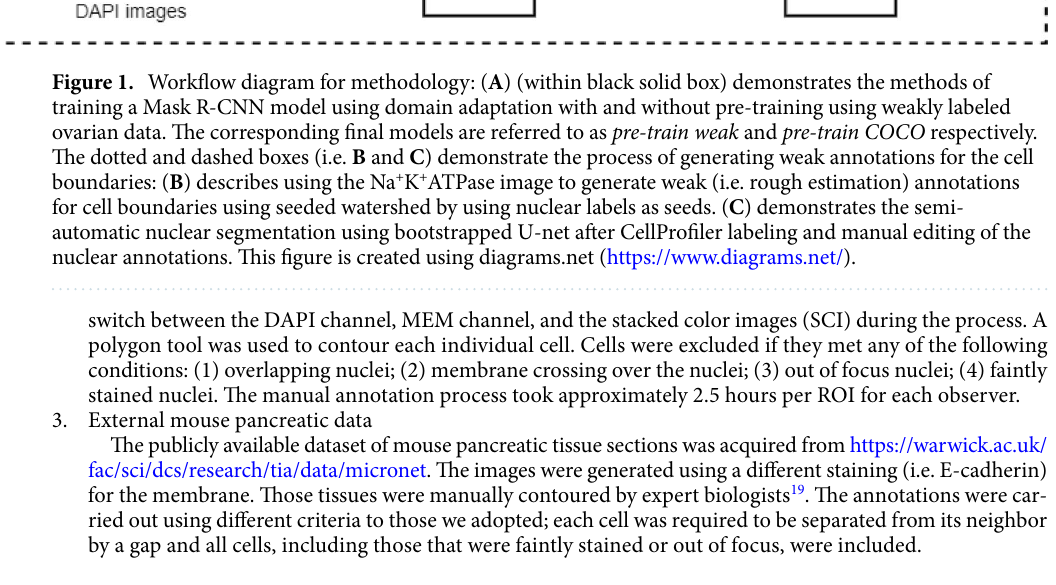
ried out using different criteria to those we adopted; each cell was required to be separated from its neighbor by a gap and all cells, including those that were faintly stained or out of focus, were included.